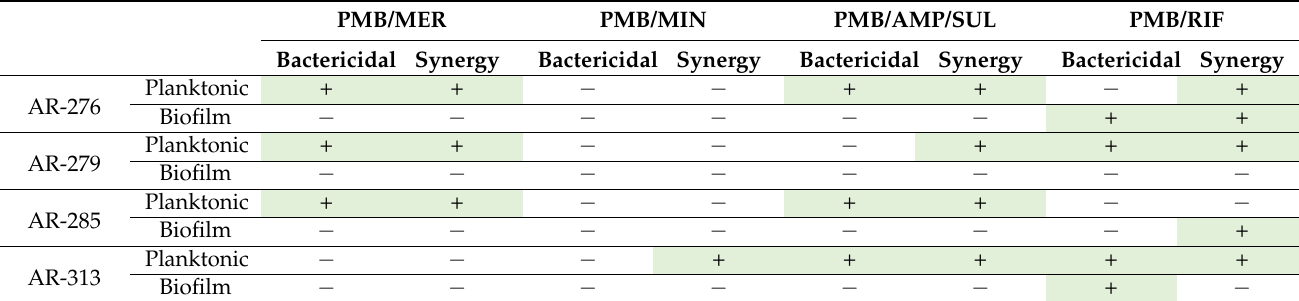
Table 2. Presence (+) or absence ( − ) of bactericidal activity and synergy for antibiotic combi- nations against planktonic and biofilm populations of CRAB isolates. Bactericidal activity was defined as a ≥ 3 log 10 CFU/mL reduction in viable cell count at 24 h and synergy was defined as a ≥ 2 log 10 CFU/mL reduction by the combination compared to the most active agent alone at 24 h. PMB, polymyxin B; MER, meropenem; MIN, minocycline; AMP/SUL, ampicillin/sulbactam; RIF,